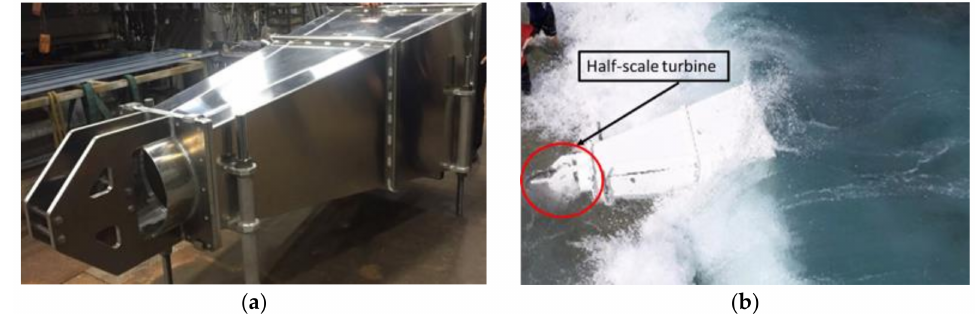
Figure 3. The early prototype of the duct design made from aluminum during fabrication ( a ); and during the field test ( b ). The model was painted white for protection against corrosion. The half-scale turbine was attached to the outlet of the duct during